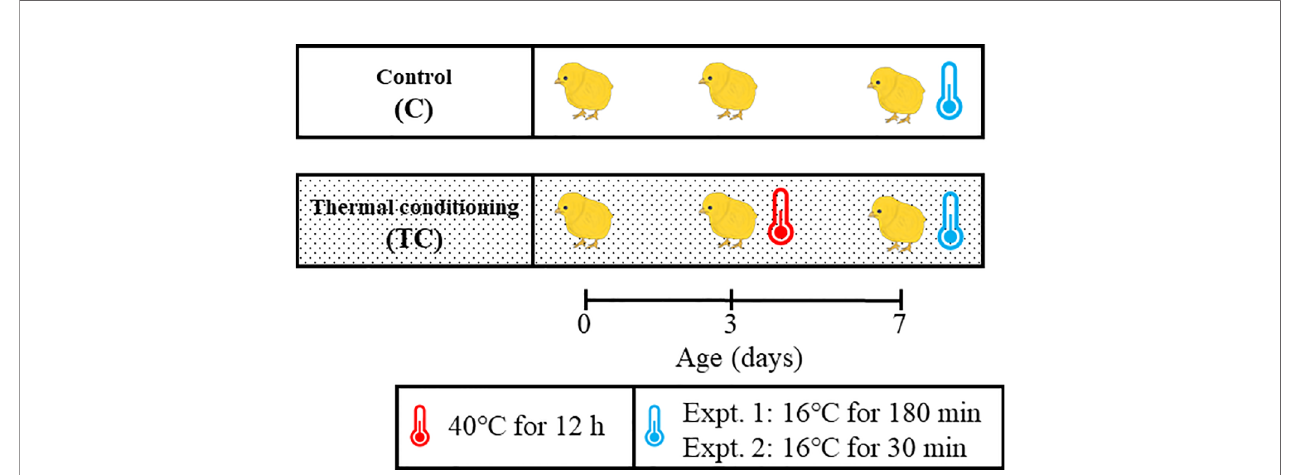
FIGURE 1 | Experiment design for this study. A thermal conditioning group (TC) was exposed to 40°C for 12 hours at 3 days of age. At 7 days of age, both TC and control groups (C) were exposed to a low temperature environment (16°C) for 180 minutes in experiment and for 30 minutes in experiment 2. Control chicks were kept in their thermoneutral zone until the low temperature